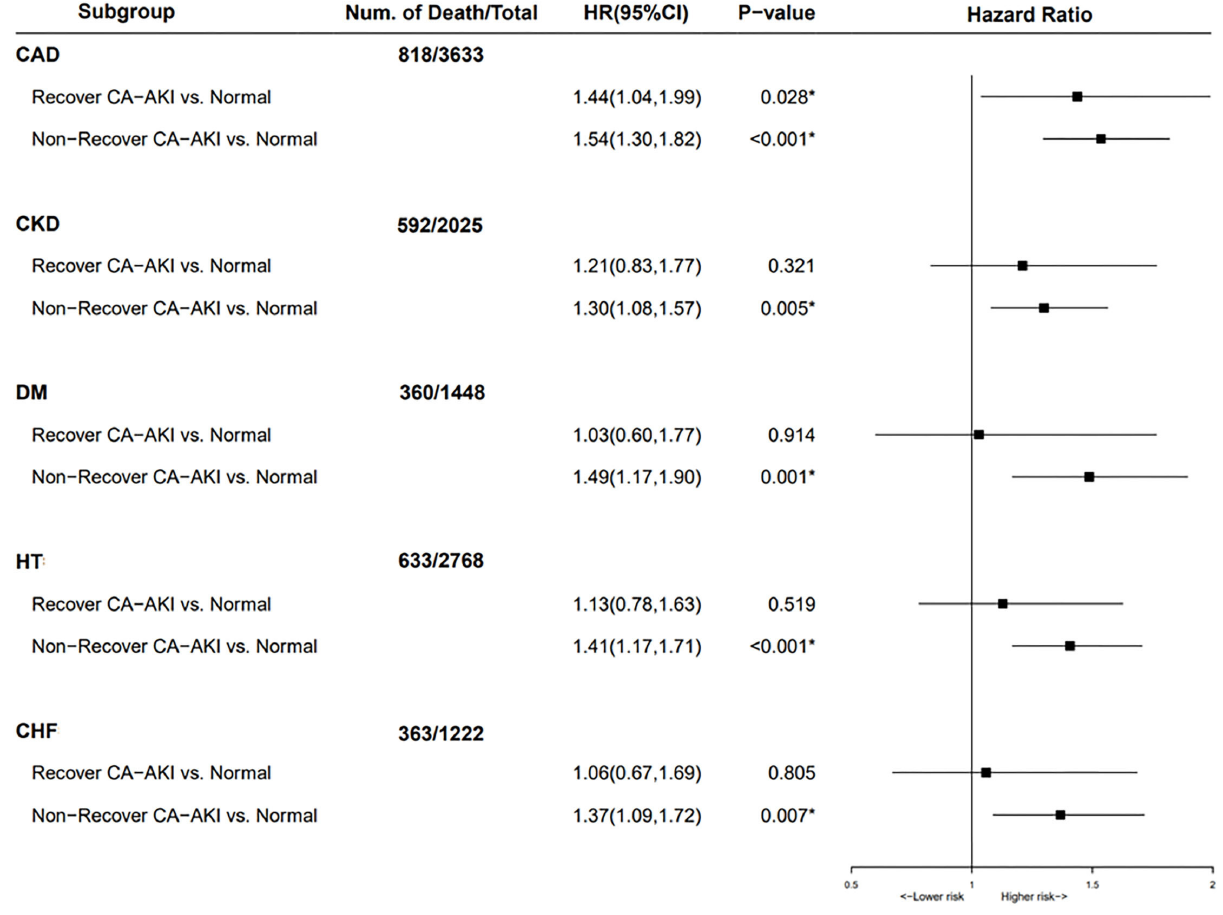
FIGURE 4 | Subgroup analysis for mortality stratified according to no contrast-associated acute kidney injury (CA-AKI), recovered CA-AKI, and non-recovered CA-AKI. Adjusted for age>75 years, gender, diabetes mellitus, anemia, chronic heart failure, hypertension, chronic kidney disease (CKD), albumin, percutaneous coronary intervention (PCI), contrast media volume, and acute myocardial infarction (AMI). * p <